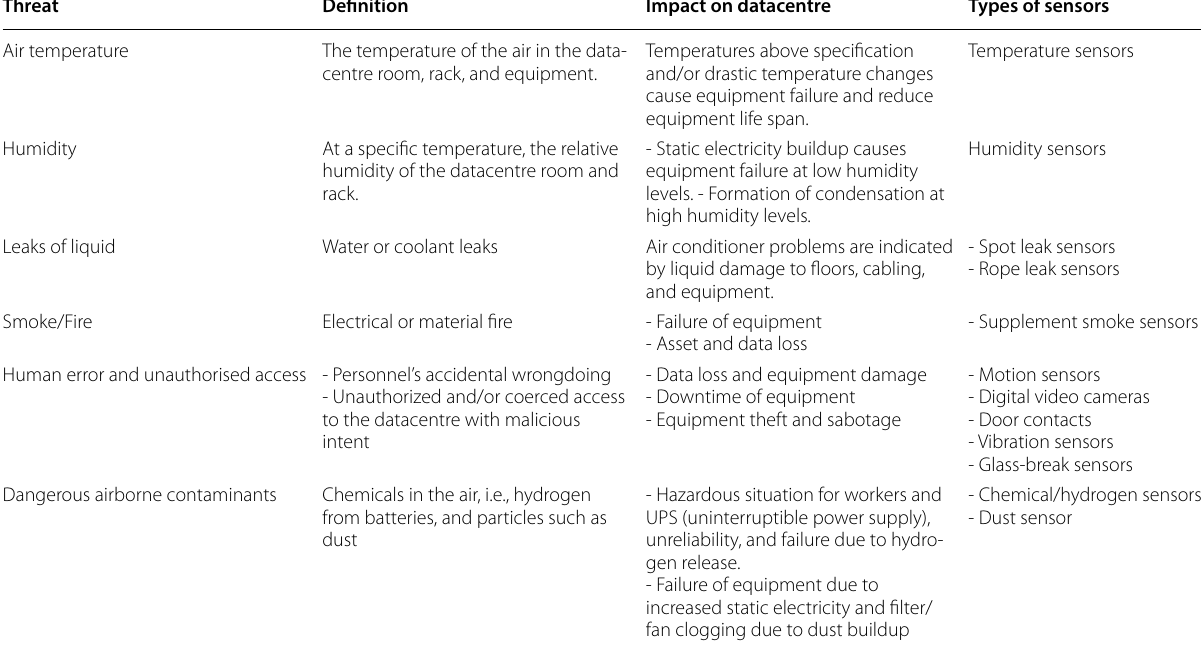
Table 2 Summary of the physical threat to the datacentre server room